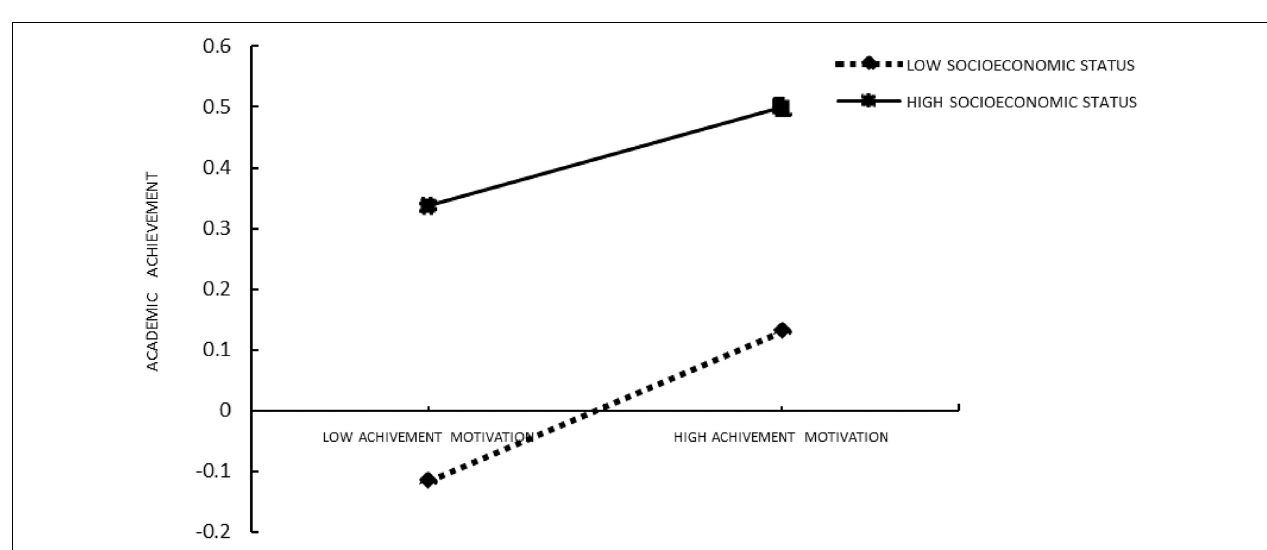
FIGURE 2 | Socioeconomic status moderated the relation between breakfast consumption and academic achievement.